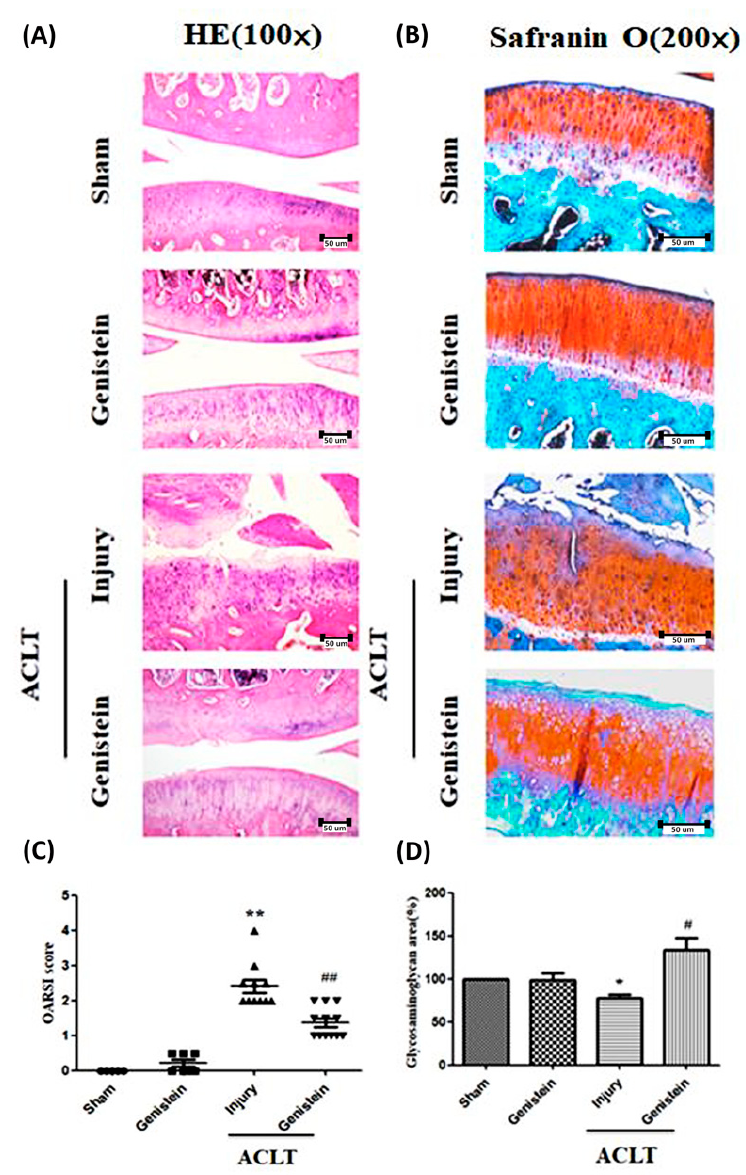
Figure 5. Genistein prevents OA disease progression in a rat model . ( A ) Representative joint sections were obtained from each group of rats at 3 months after treatment with genistein ( n = 3 for each group). H&E staining revealed signs of inflammation (100×), ( B ) and safranin O staining revealed a reduction in GAG (200×). ( C ) Inflammation and cartilage damage were assessed by assigning OARSI scores to H&E staining results. ( D ) GAG loss status was based on safranin O staining results obtained using Image J software. Significance was determined using a t -test. Significant differences between the genistein group and the sham control group are indicated using an asterix (*); significant differences between the genistein group and the ACLT injury group are indicated using a pound sign ( # ). *, # p < 0.05; **, ## p < 0.01. Scale bars = 50 um.